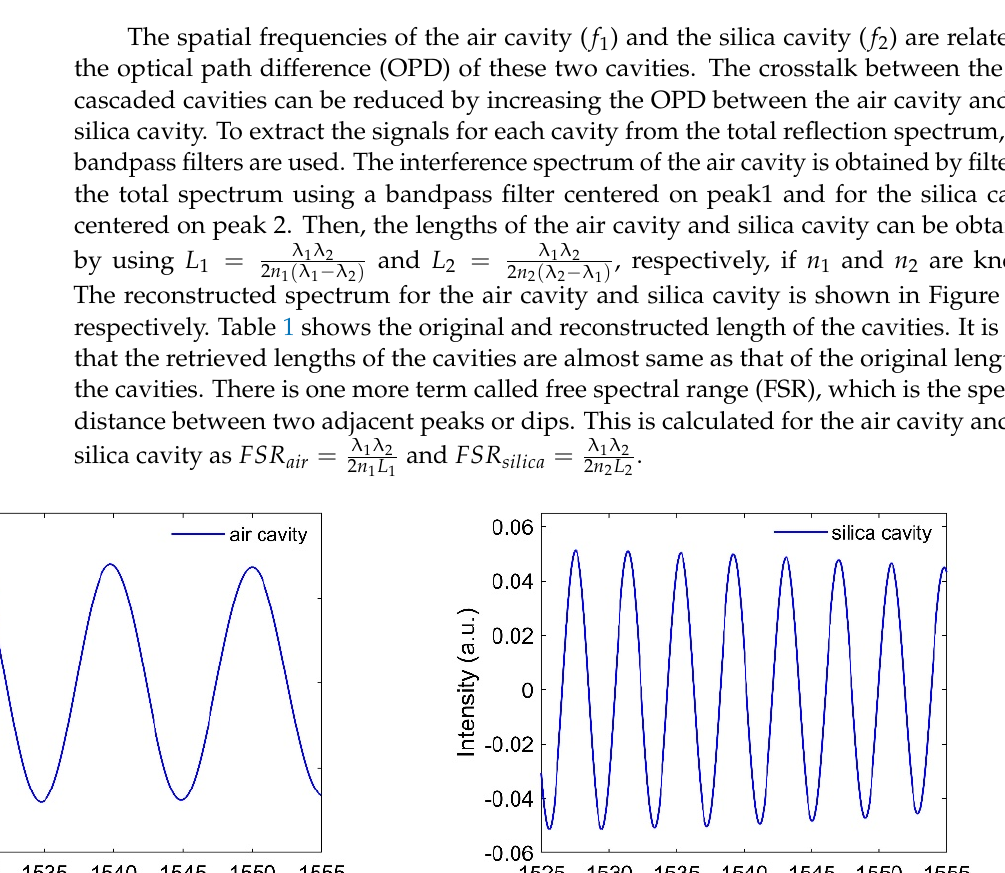
Figure 2. ( a ) total spectrum of the cascaded FPI and ( b ) the spatial frequency distribution of the total spectrum using FFT.